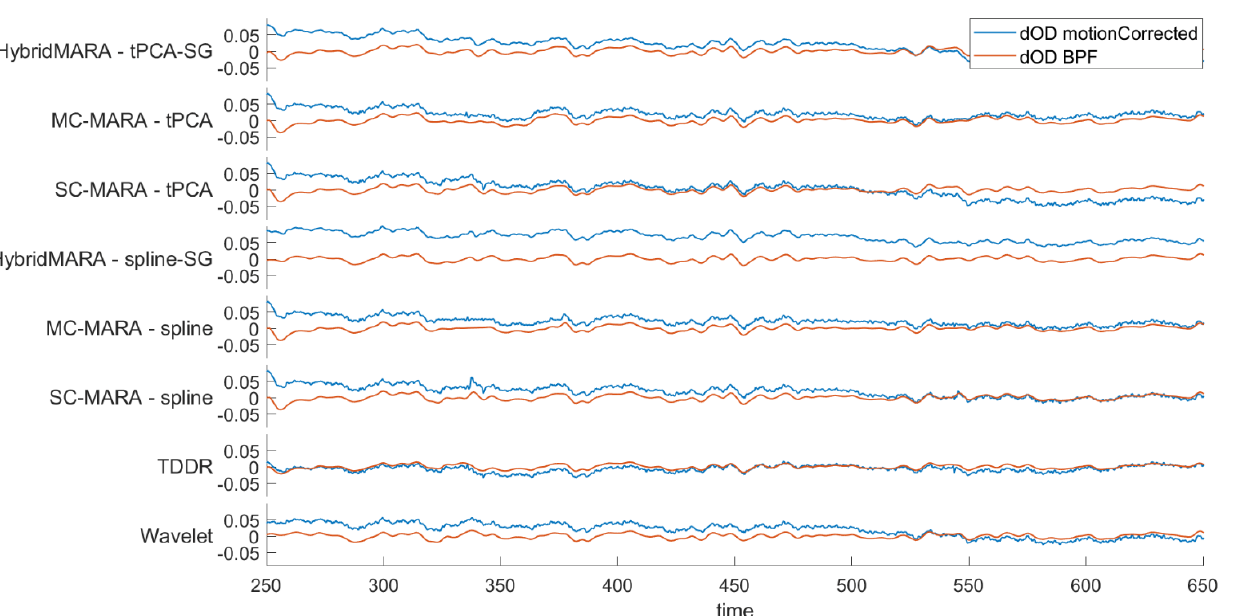
Table 1. Mean (std) Power Ratio at the passband ( 𝑃𝑅 𝑤𝑏 ) and stopband ( 𝑃𝑅 𝑜𝑏 ) in the 𝑓 = [0.01 − 0.2] Hz range across subjects and measurement channels. The leftmost column indicates the adopted MA reduction algorithm prior to the BPF step. 𝑷𝑹 𝒘𝒃